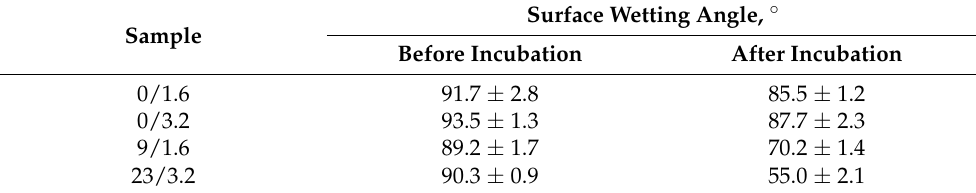
Figure 8. Results of the wettability analysis of samples before and after incubation. In Table 2. average values of measured contact angles are given. Table 2. Surface wetting angles of